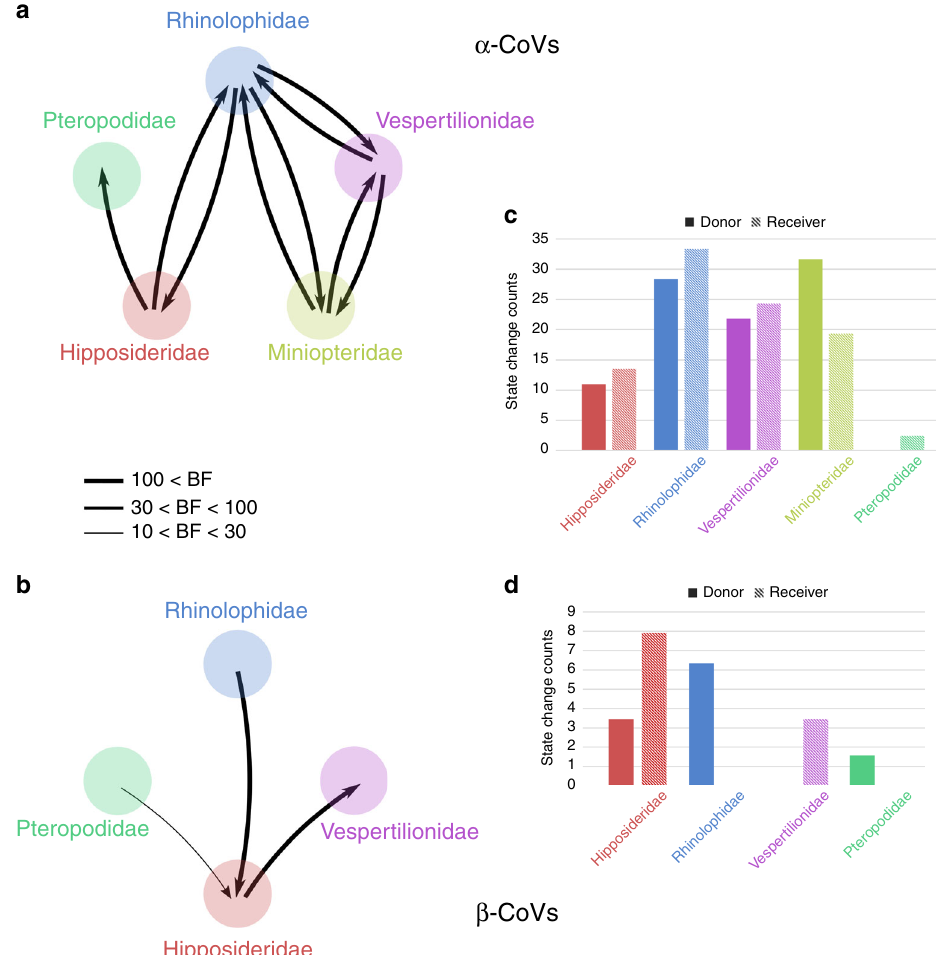
Fig. 4 Inter-family host switches. Strongly supported host switches between bat families for α -CoVs ( a ) and β -CoVs ( b ). Arrows indicate the direction of the switch; arrow thickness is proportional to the switch signi fi cance level, only host switches supported by strong Bayes factor (BF) > 10 are shown. Histograms of total number of host-switching events (state changes counts using Markov jumps) from/to each bat family along the signi fi cant inter-family switches for α -CoVs ( c ) and β -CoVs ( d